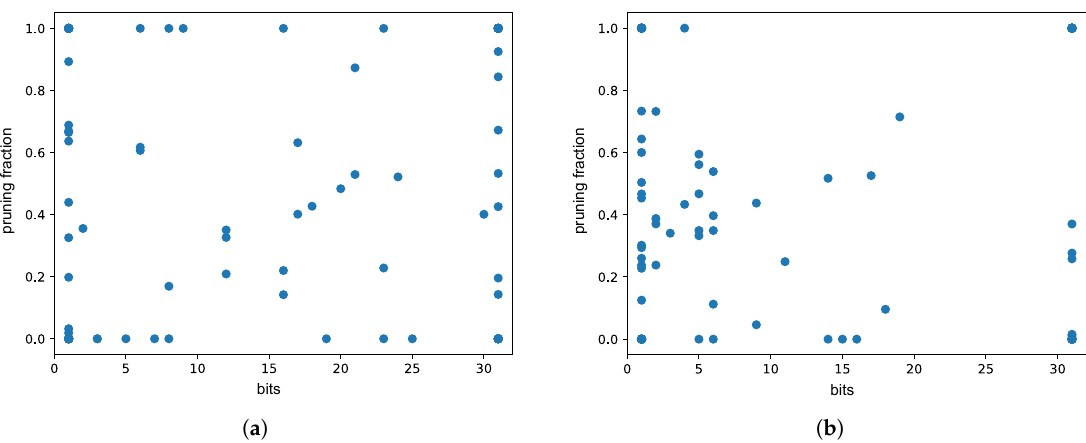
Figure 6. Sample multi-objective covariance matrix adaptation evolution strategy phases. ( a ) Explore— algorithm samples the whole search space; ( b ) exploit—algorithm starts to converge to the best solutions.